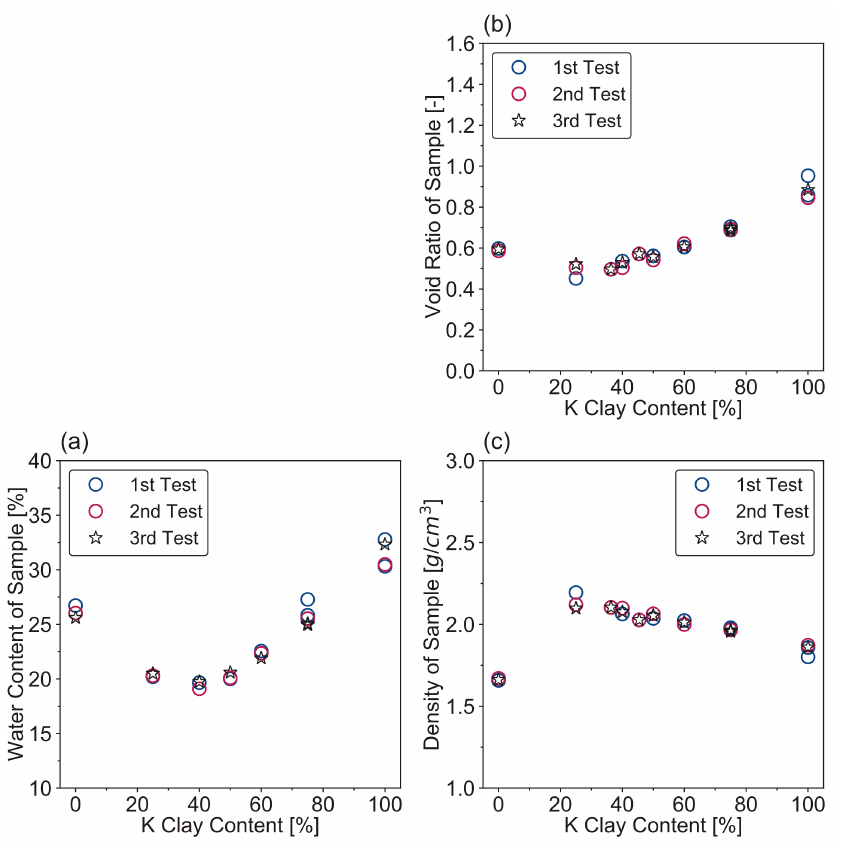
Figure 8. Assessment of samples’ repeatability by: ( a ) water content, ( b ) void ratio, and ( c ) density after S1 preconsolidation as function of K clay